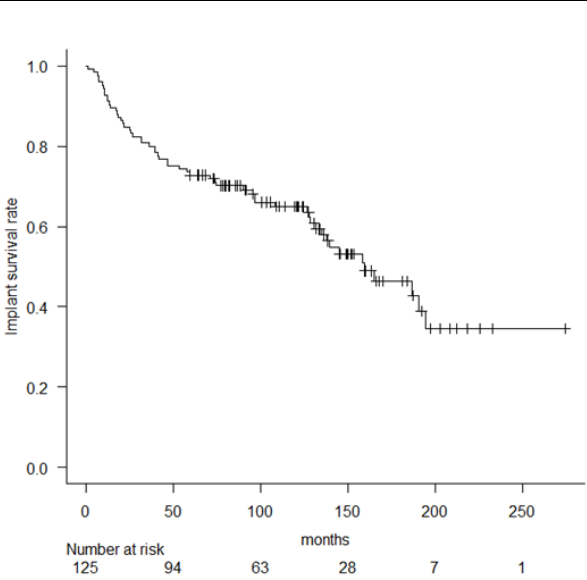
Figure 3. Kaplan–Meier curve showing implant survival rate (major revision).